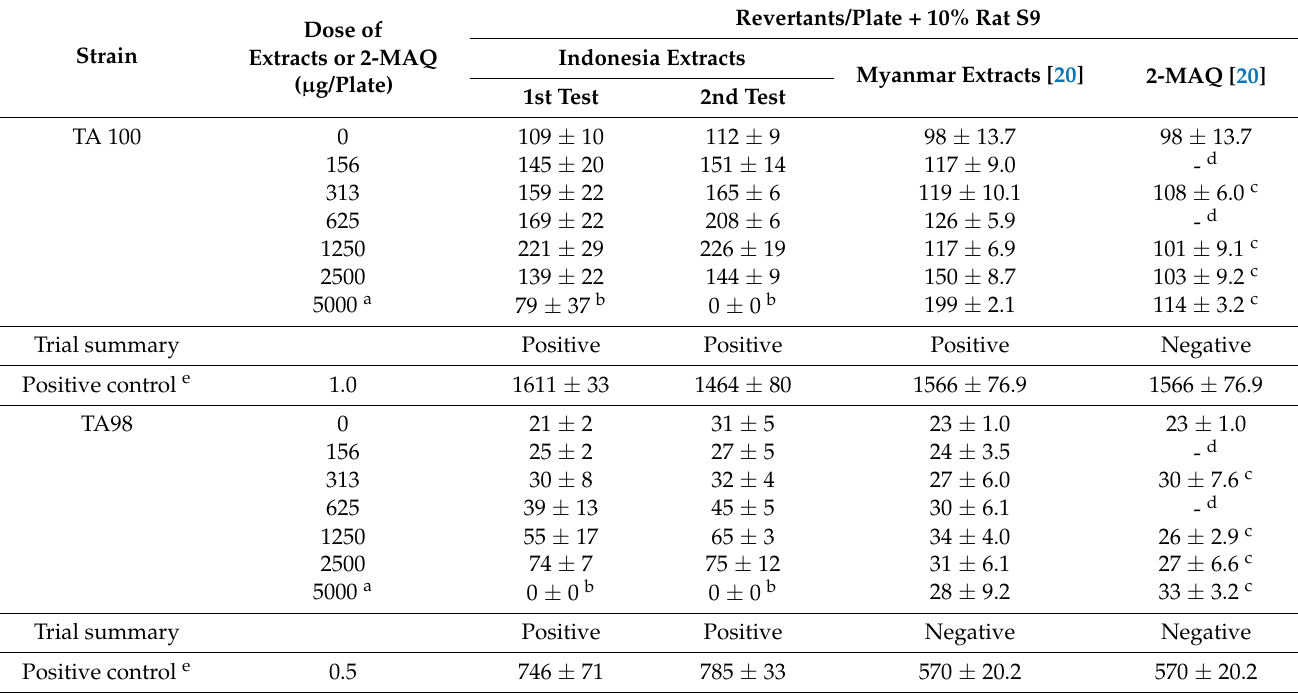
Table 5. Mutagenicity of Indonesia teak wood extracts and 2-methylanthraquinone (2-MAQ) in Salmonella typhimurium Ames